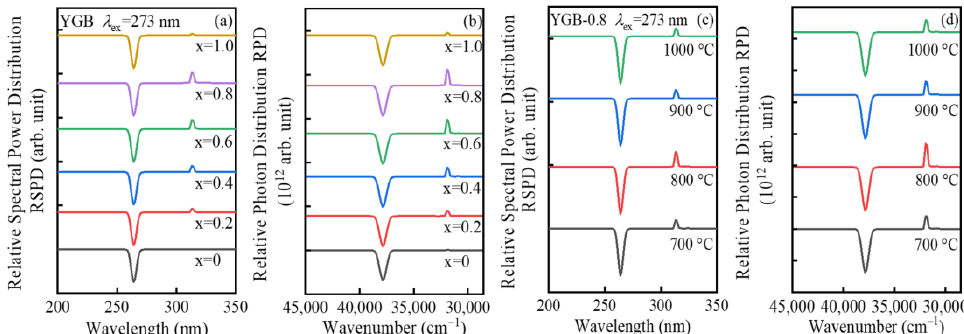
Figure 7. ( a , c ) Relative spectral power distributions and ( b , d ) relative photon distributions of Y 0 . 9 (Gd x Bi 1−x ) 0 . 1 BO 3 (x = 0, 0.2, 0.4, 0.6, 0.8 and 1.0) and YGB-0.8 samples with different annealing temperatures from 700 °C to 1000 °C under the 273 nm excitation.